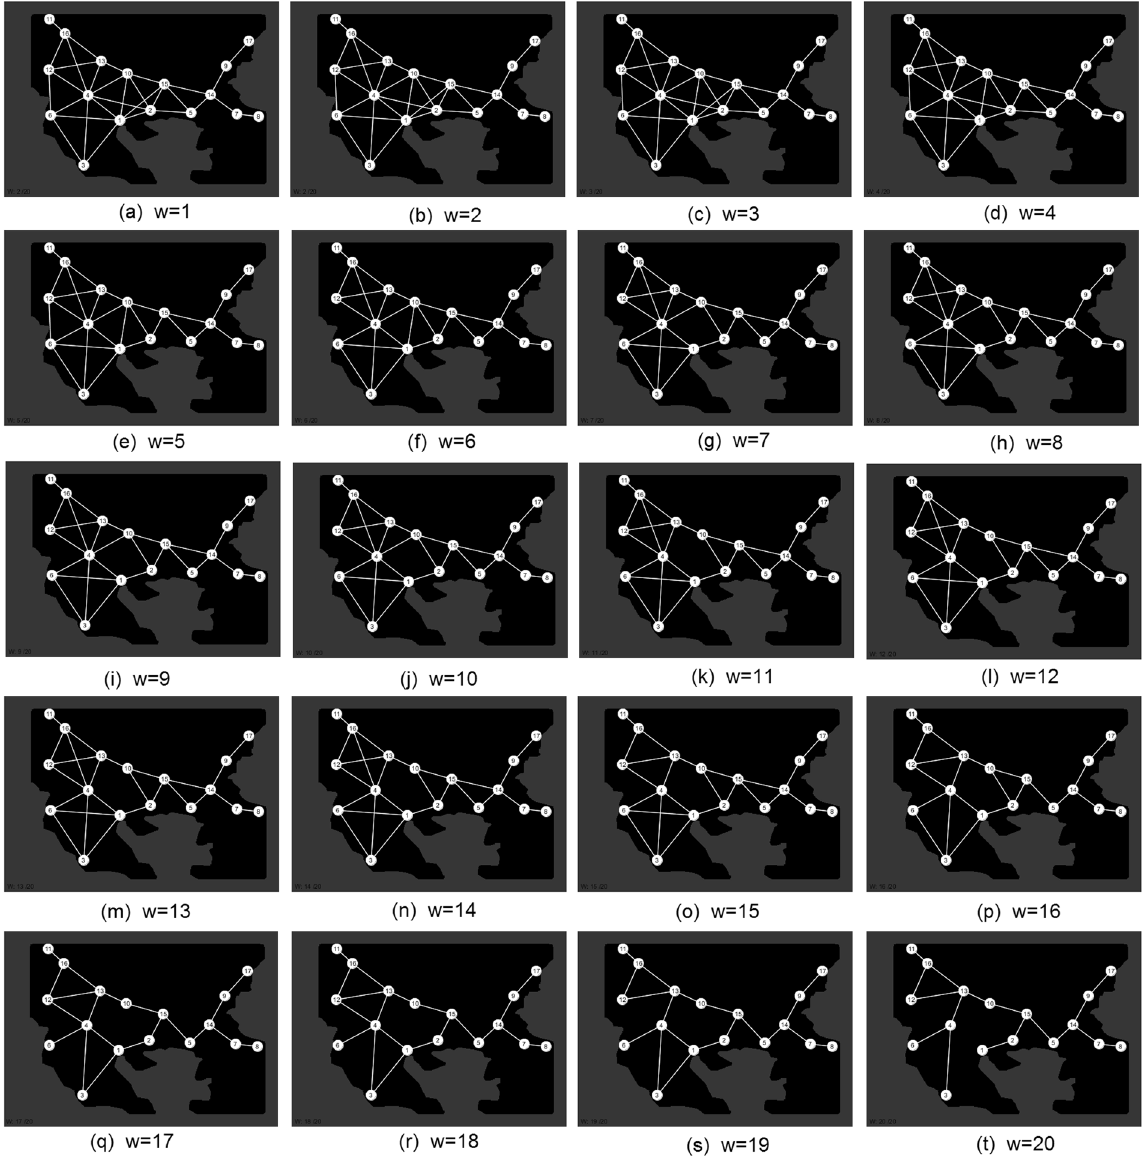
simulation results from custom Processing script (https://www.processing.org/) by author